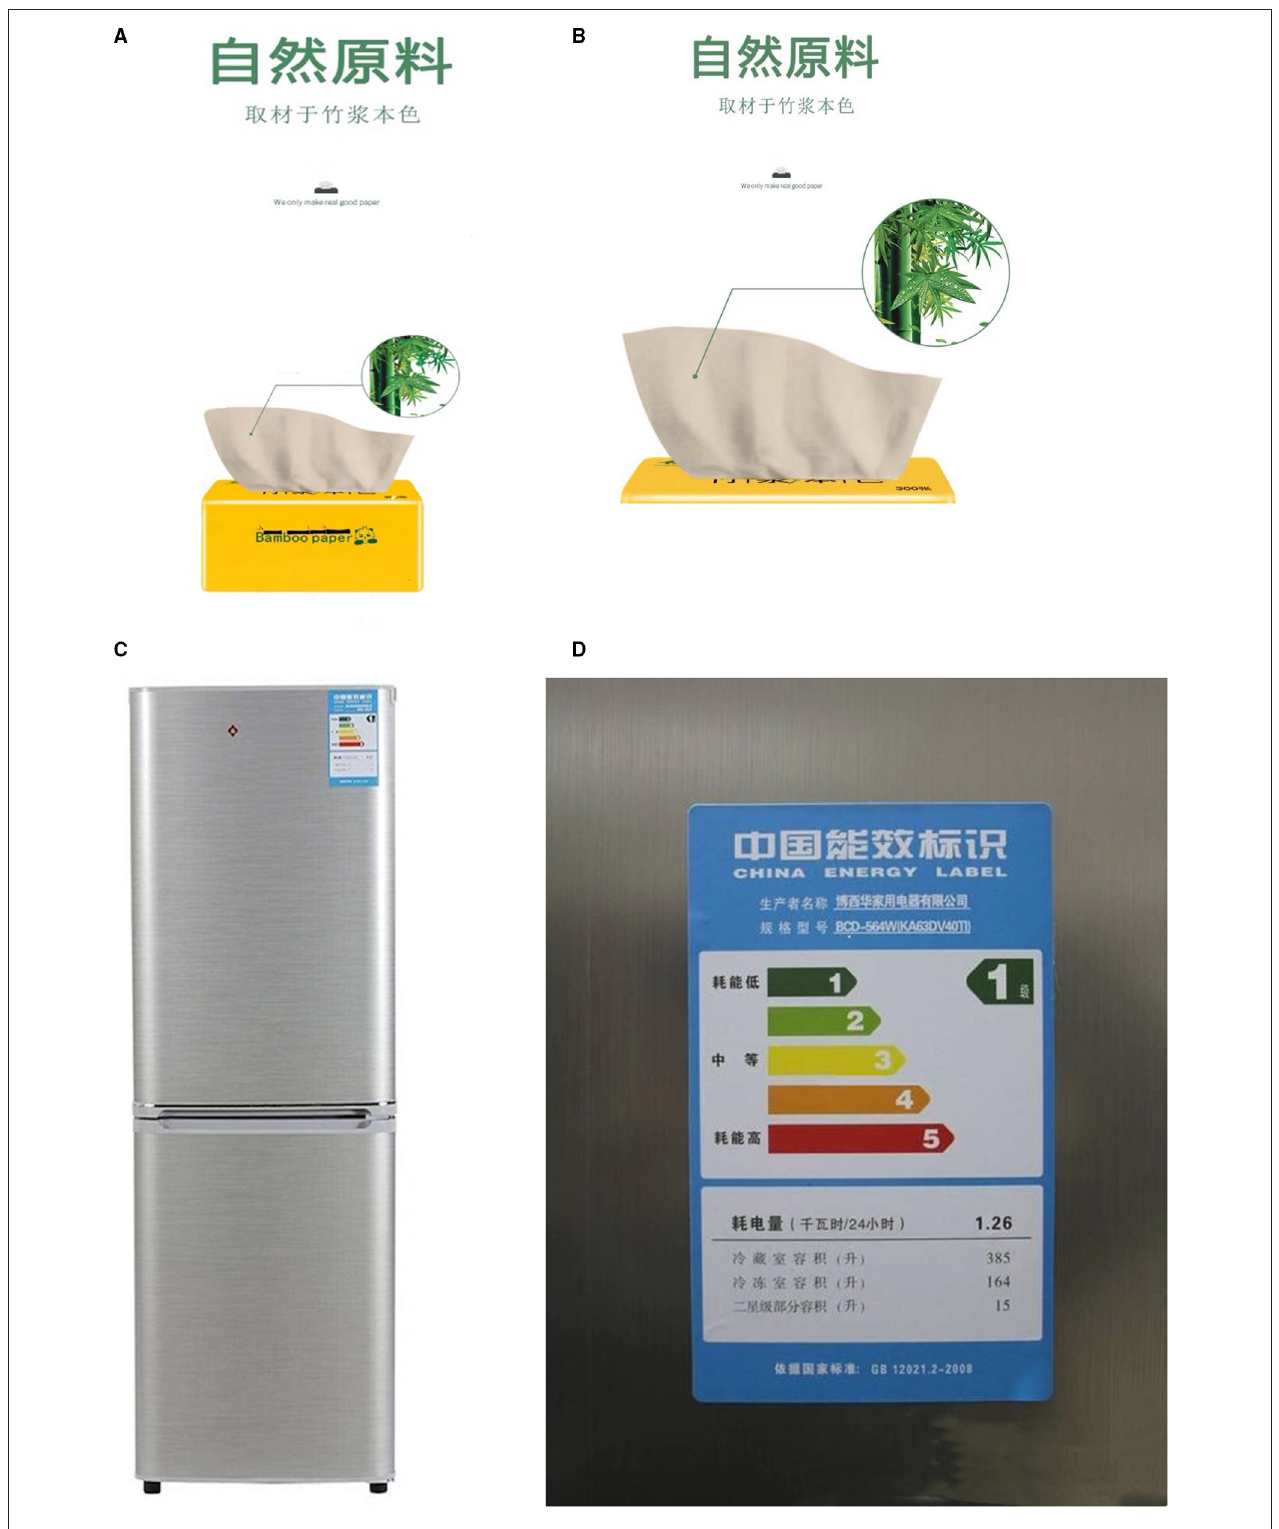
FIGURE 4 | Bamboo pulp tissue used with full-length shot (A) and close-up shot (B) , Energy efficient refrigerator with full-length shot (C) and close-up shot (D) (Image source: https://image.baidu.com).